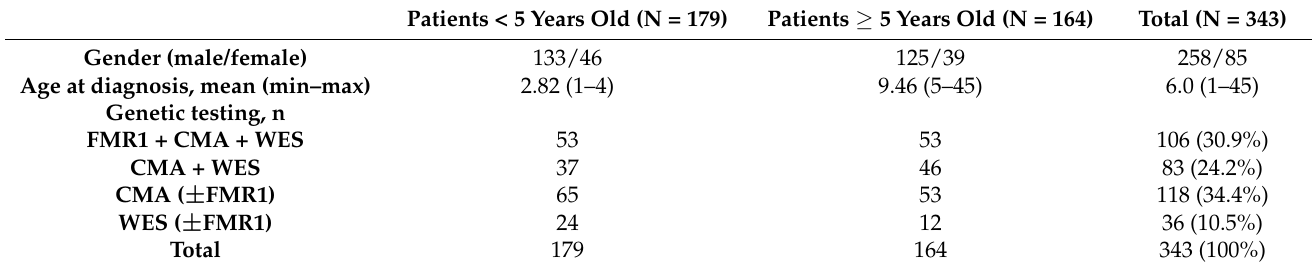
Table 1. Demographics and genetic tests performed in each group of autism spectrum disorder (ASD) patients. Patients < 5 Years Old (N = 179) Patients ≥ 5 Years Old (N =